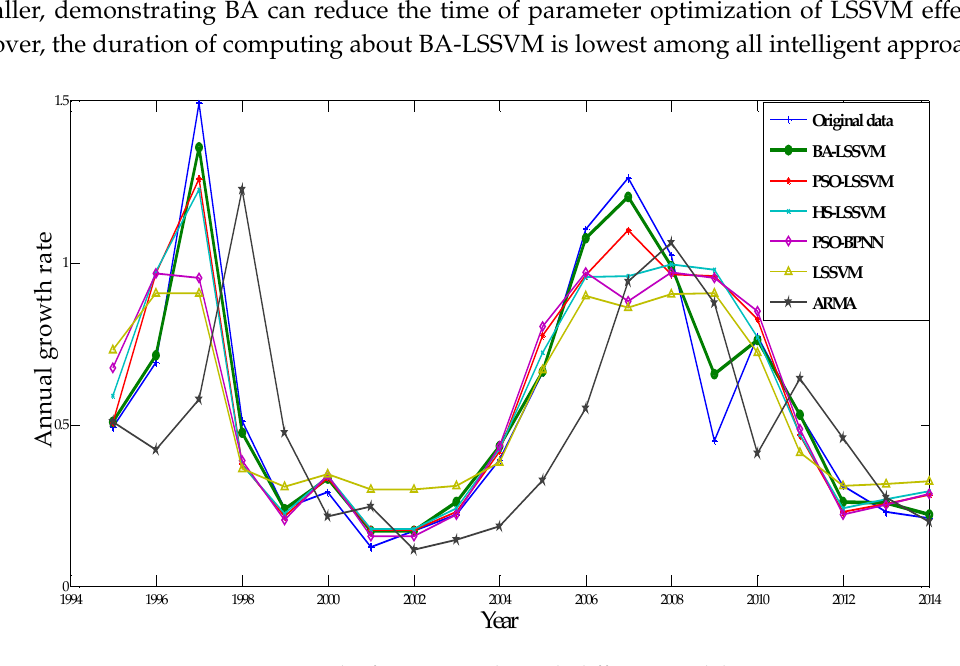
Figure 8. The forecast results with different models.